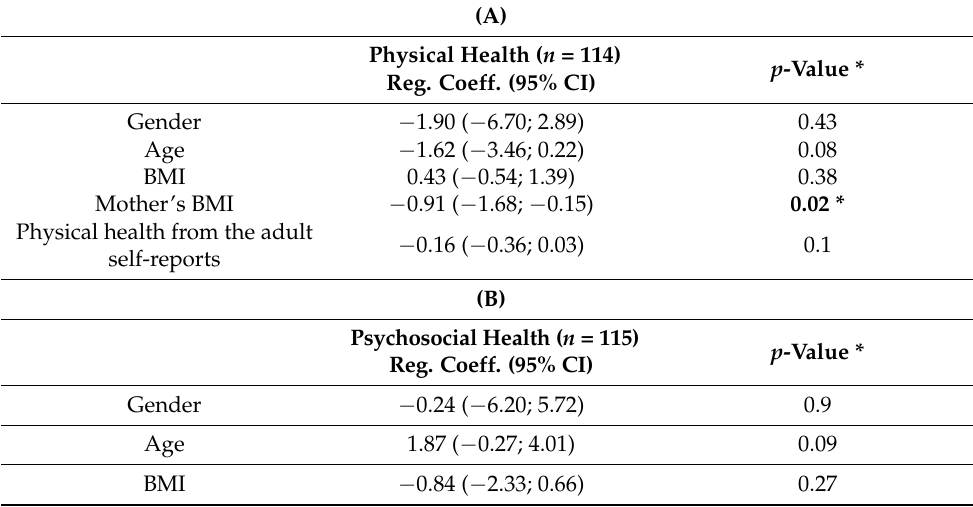
Table 3. ( A ) The associated factors of health-related quality of life in children for the physical health domain. ( B ) The associated factors of the health-related quality of life in children for the psychosocial health